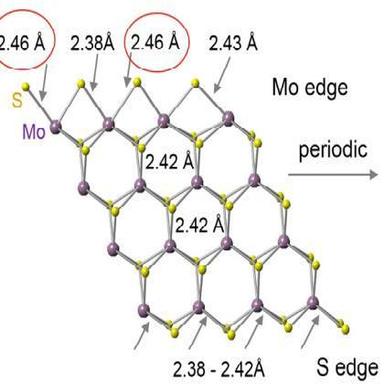
The stripe model of MoS2 optimized with DFT calculations (VDW density functional with optPBE, PAW_PBE pseudopotentials, 400 eV cutoff for plane wave basis sets, structural optimization converged at 0.03 eV/ Å max force on each atom, implemented in VASP).